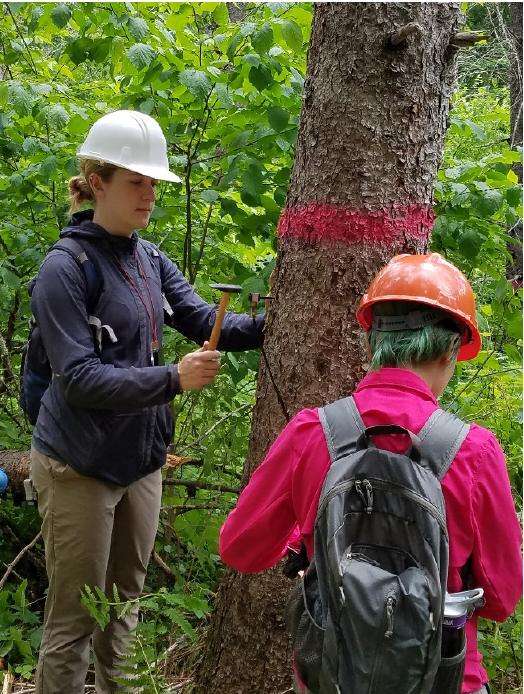
Figure 3. Transverse acoustic velocity measurements on white spruce trees using the Fakopp Mi- crosecond Timer.